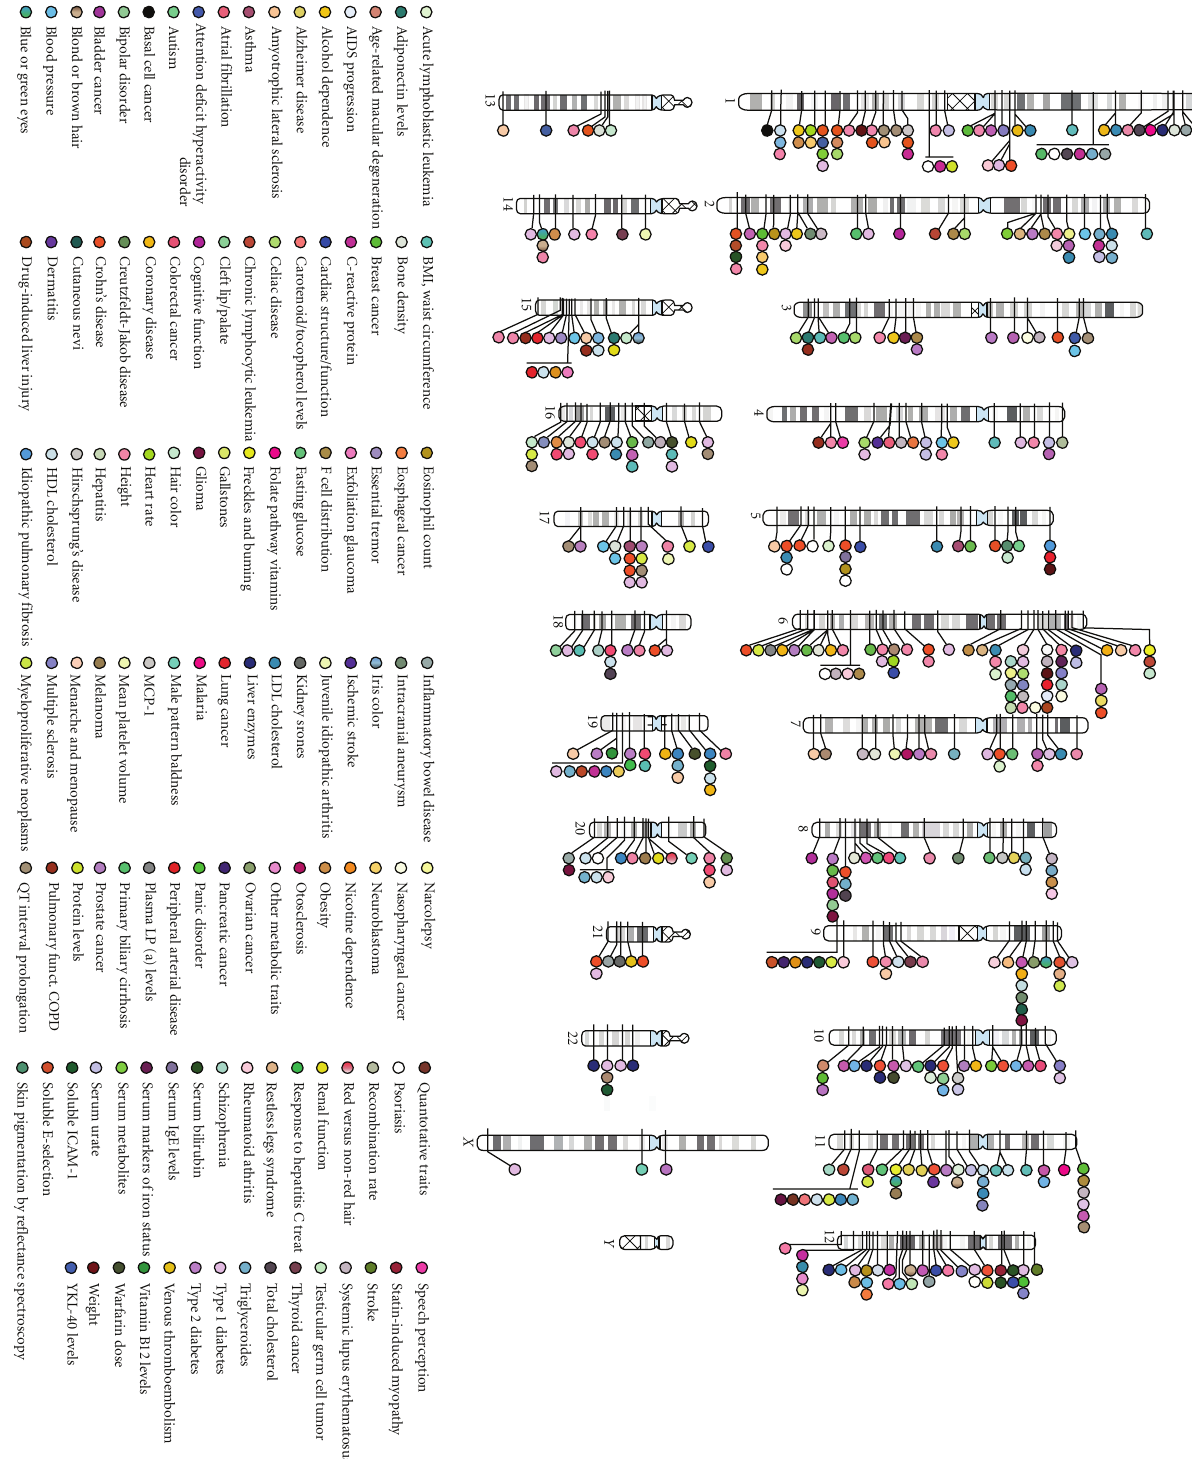
Figure 1: Published genome-wide associations until Sept. 2009. 536 published GWAS at P ≤ 5 × 10 − 8 (reproduced with permission from